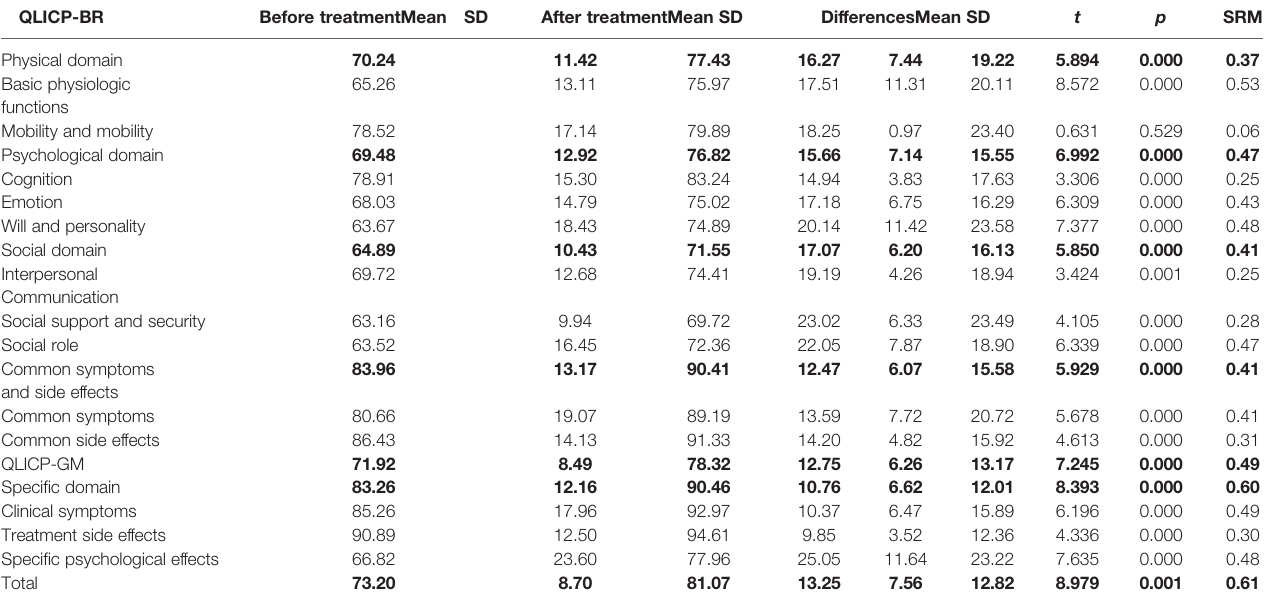
Bold values represent results for domains of the scale. Other values represent results for facets of